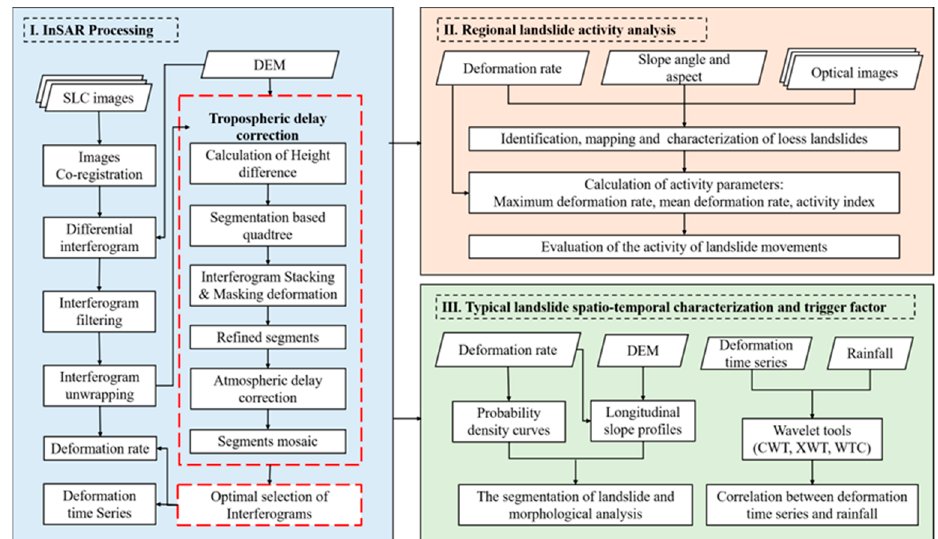
Figure 2. Flowchart of large-area landslides mapping and characterization.